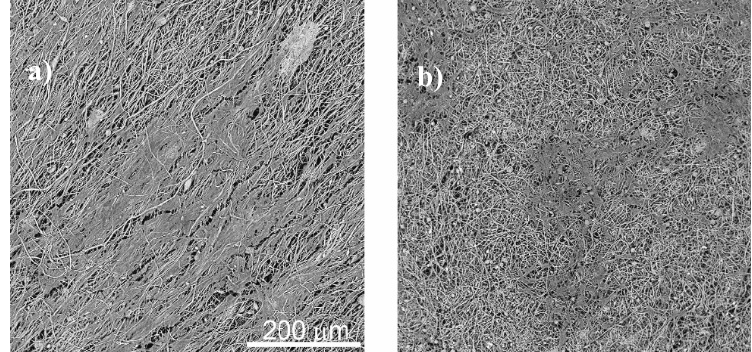
Figure 13. Cell morphology obtained by SEM of C2C12 myoblasts seeded on PVDF fibres: ( a ) O-17P and ( b ) R-17P, after three days of culture. The scale bar is 200 µm for all samples.